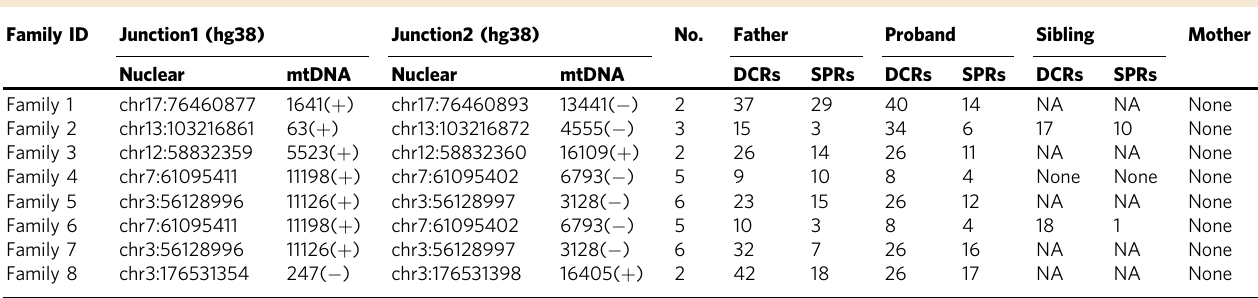
Table 1 Summary of transmitted mega-NUMTs in eight families. Family